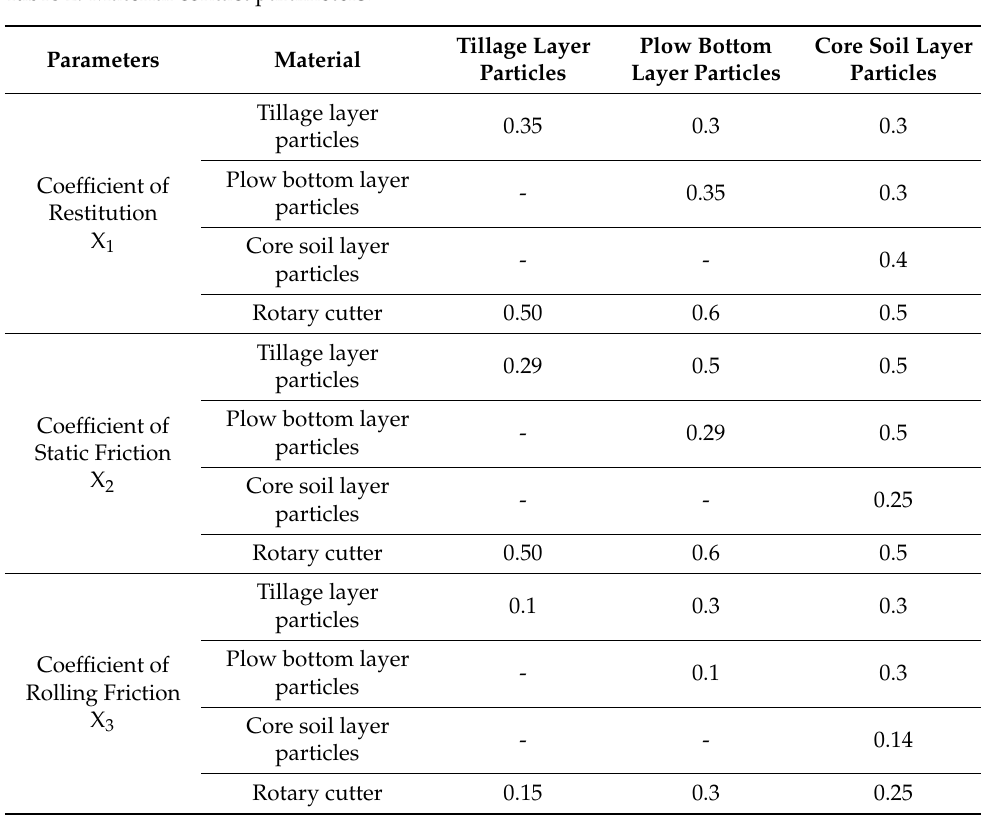
Table 2. Material contact parameters.